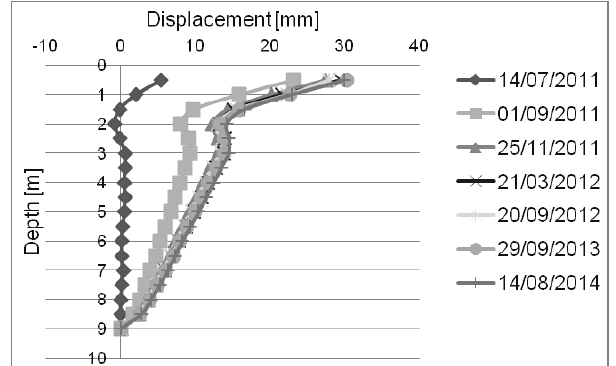
Fig. 1. Displacements from inclinometer measurements,